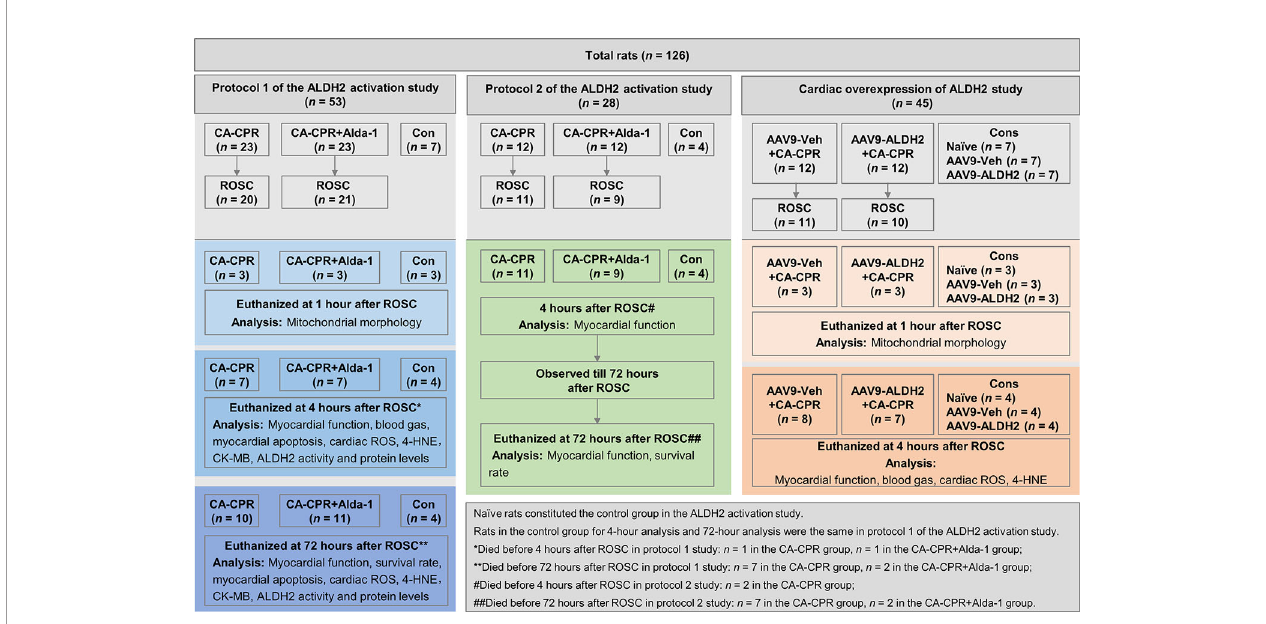
FIGURE 1 | The fl owchart of the animal